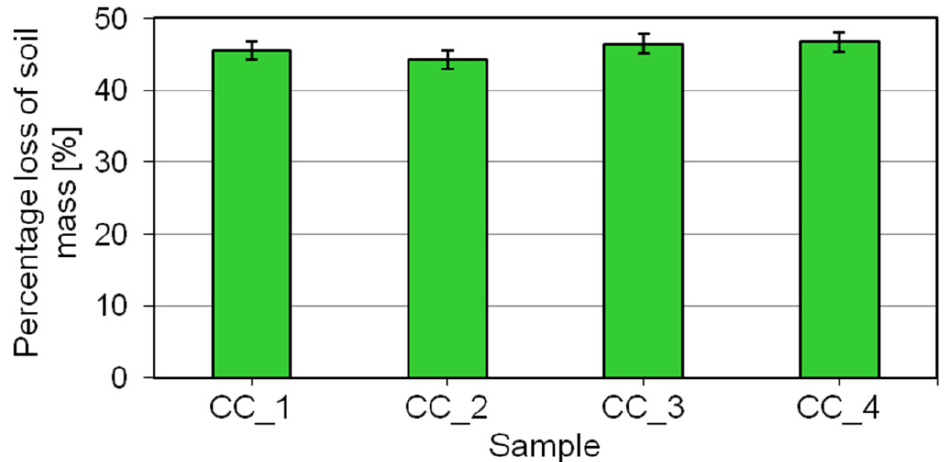
Figure 9. The evaluation of detergent properties for the shower gels. Table 3. Color parameters for cosmetic (shower